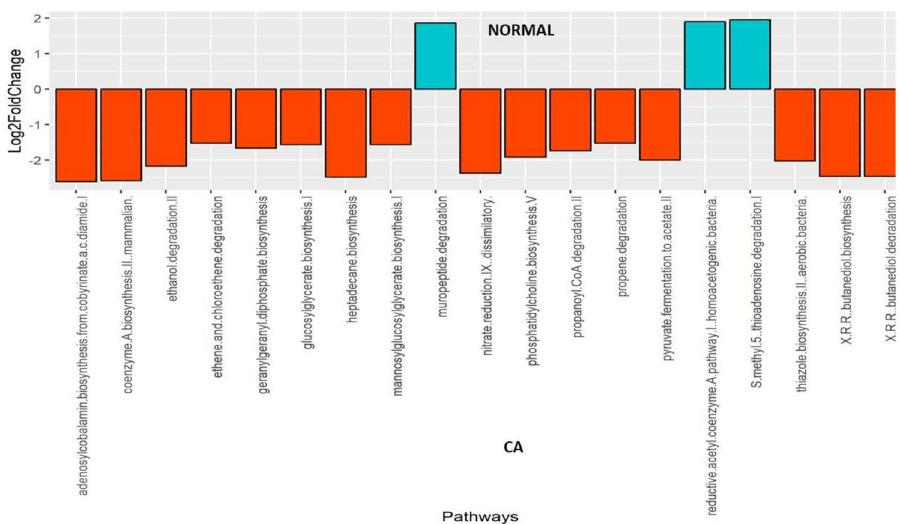
Figure 3. Differentially abundant metabolic pathways identified in cancer and normal tissues by DESeq2 Analysis. Increased abundance of sixteen bacterial metabolic pathways were present in tumor tissue relative to